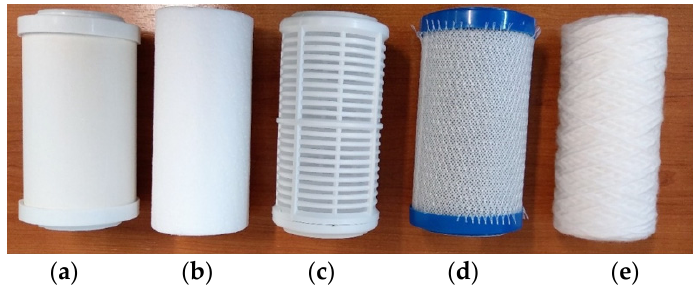
Figure 1. Analyzed filters: ( a ) Ceramic filter cartridge used for mechanical filtration of particles such as rust, sand, or other impurities, up to 0.3 µ m. The maximum operating temperature is 30 ◦ C. It can improve taste and smell from the water and has a resin component. ( b ) Polypropylene filter cartridge obtained by melting and expanding polypropylene; it can retain mechanical impurities (sand, rust, etc.) with the size up to 5 µ m. The maximum operating temperature is 40 ◦ C. ( c ) Washable filter cartridge retains impurities (sand, coal dust, sludge, rust, and other sediments) up to 70 µ m. It has the advantage of reusing by washing. The maximum operating temperature is 70 ◦ C. ( d ) Pressed activated carbon cartridge obtained by carbon-block technology; it can retain impurities or organic substances up to 1 µ m and remove chlorine from the water (unpleasant taste and smell). The maximum operating temperature is 45 ◦ C. It can improve taste and smell from the water but can also remove heavy metals. ( e ) Fabric filter cartridge made of polypropylene retains